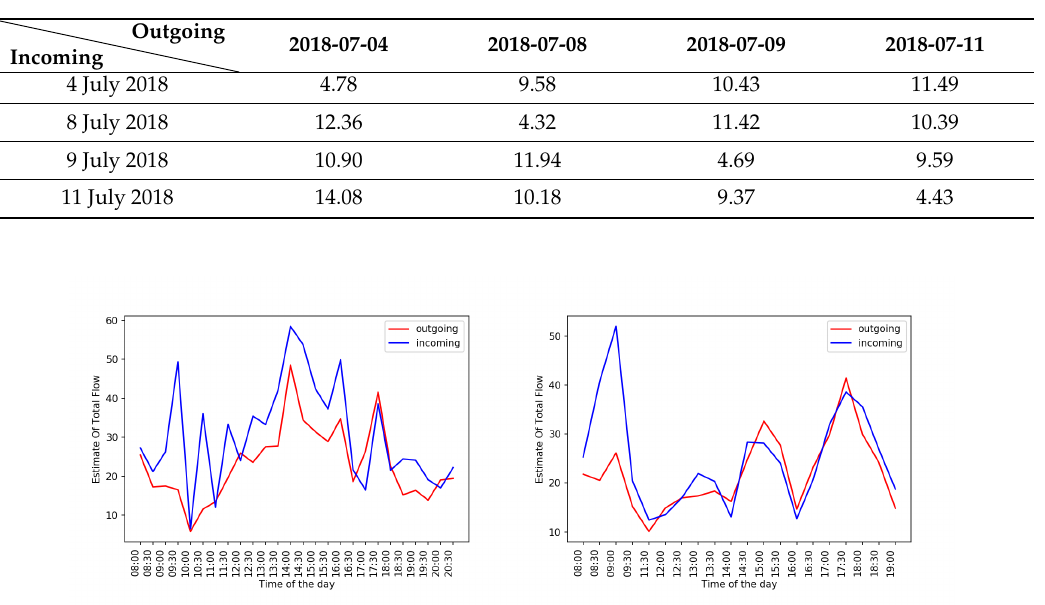
Figure 10. Plots of I v and O v values computed by the proposed algorithm for 4, 8, 9, and 11 July 2018. Table 5. DTW similarity scores between outgoing and incoming traffic curves in Figure 10.